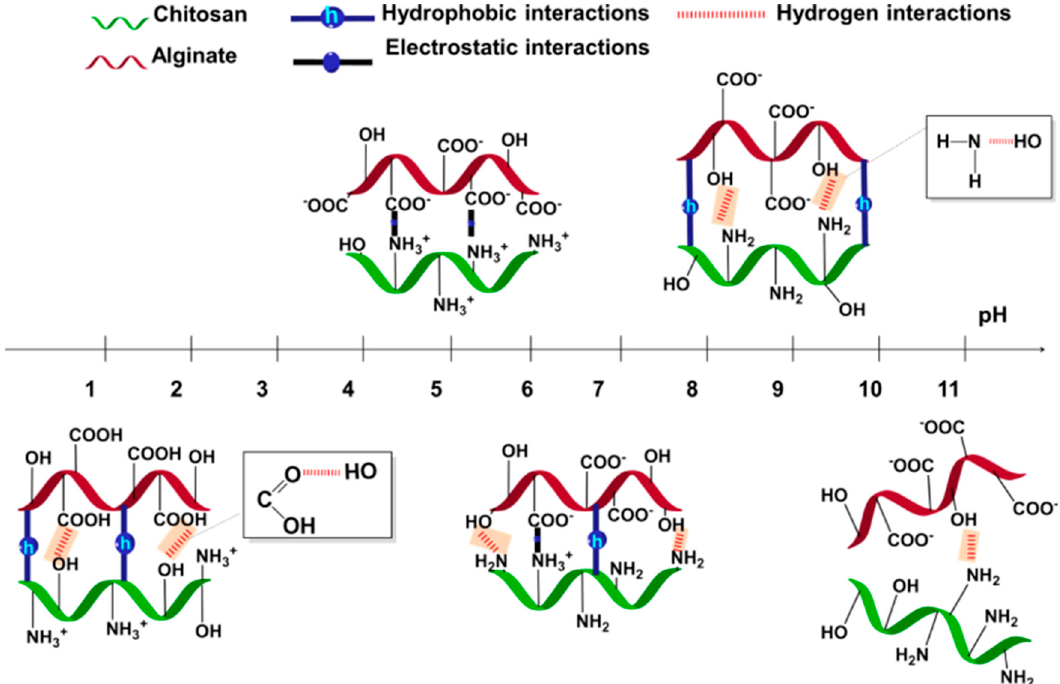
Figure 11. Schematic demonstrating the effect of pH on the molecular mobility of multi-layered films, considering the different intermolecular interactions behind them. Figure taken from reference [168], copyright © 2020 American Chemical Society.